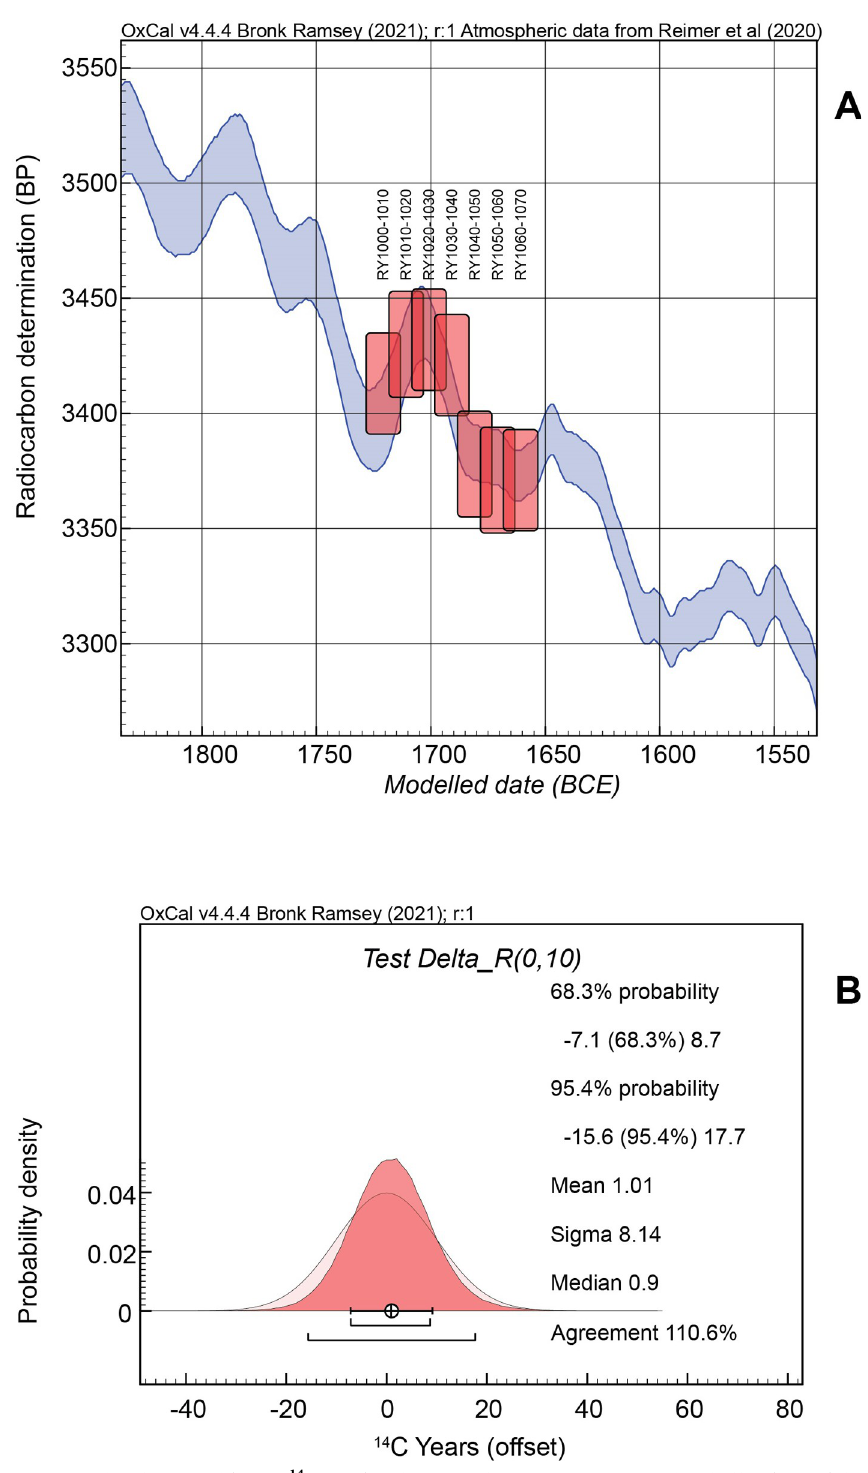
Fig 5. Results of a neutral (0 ± 10 14 C years) Delta_R test for a growing season related offset (GSRO) for the tree- ring defined time-series from an oak sample from LMIA Miletos, western Anatolia. (A) The seven weighted average 14 C values [132] for 11 tree-rings (years) samples, Relative Years (RY)1000-1010 ... to RY1060-1070, each spaced (mid-points of each block) 10 rings = calendar years apart (from pairs of 14 C data in each case: see S1A Table nos. 20–33) show a good, ordered, fit against the IntCal20 14 C calibration curve [41]. The IntCal20 curve is shown as a